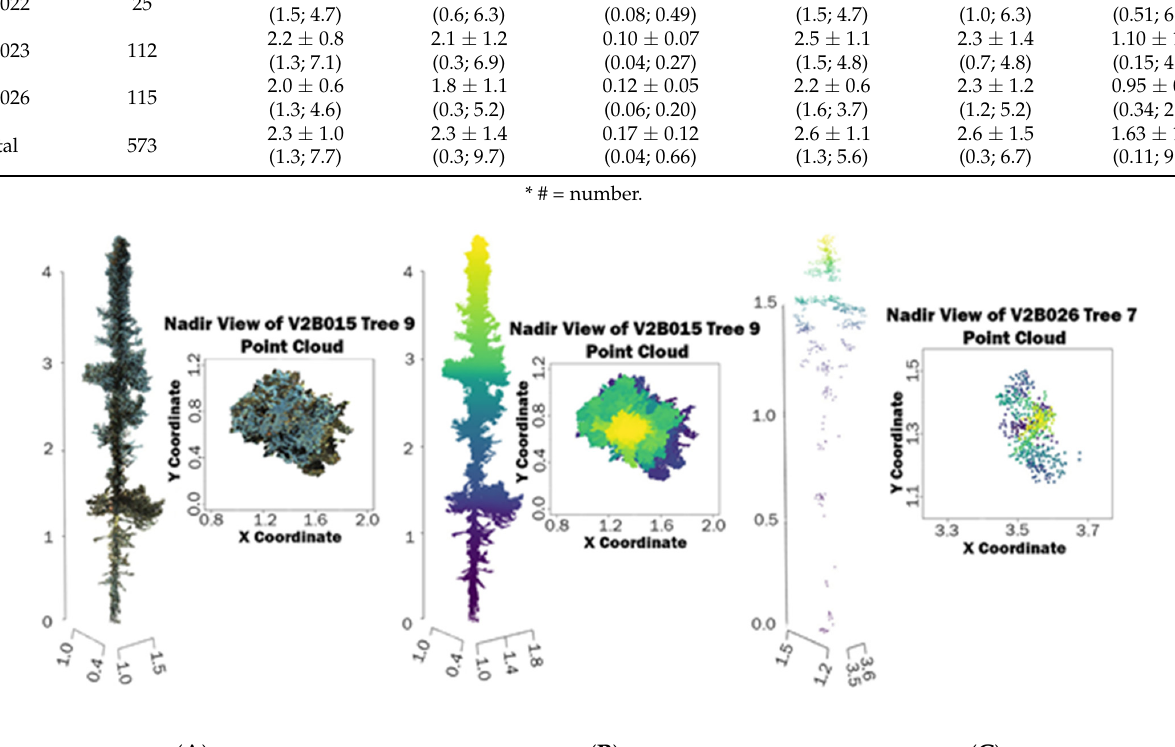
Figure 3. A comparison of an unoccluded tree point cloud (left) versus an occluded one (right). ( A ) A true colour view (silhouette and overhead) of the point cloud corresponding to harvested tree #9 from plot V2B015; this point cloud is full, detailed, and shows the complete tree structure, making it easy to obtain measurements from it. ( B ) Same as ( A ) but using a colour ramp based on height. ( C ) Harvested tree #7 from plot V2B026; this point cloud is incomplete because of occlusion, making it difficult to use in our workflow.